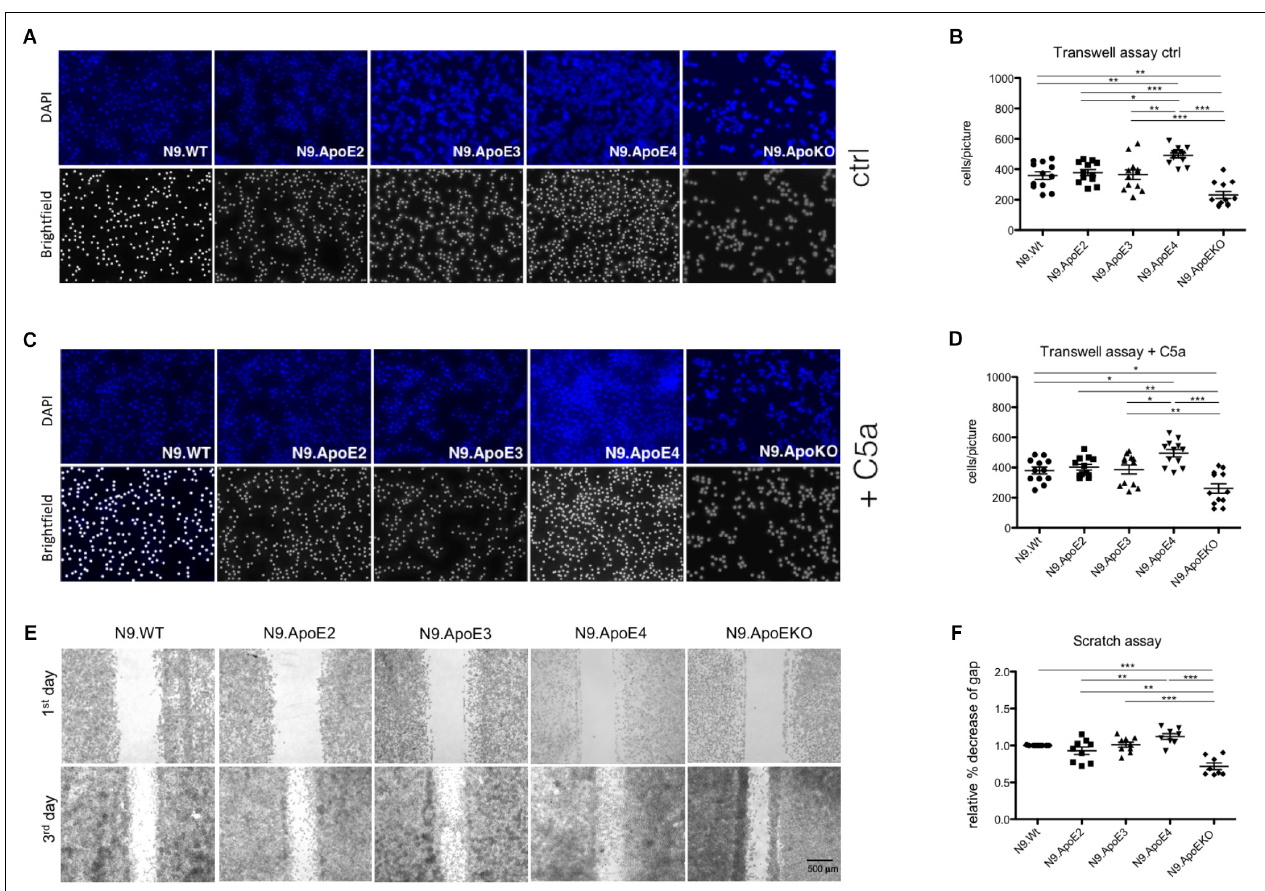
FIGURE 4 | Migration of microglia cells is ApoE-isoform dependent. (A) Representative images of motility in transwell assays and (B) quantification of migrating cell number demonstrate a significant increase in cell motility of N9.ApoE4 and a significant decrease of N9.ApoEKO ( n = 12; magnification 10 × ). (C,D) Representative images of migrating cells toward C5a (20 ng/ml) display a significant increase in cell motility of N9.ApoE4 and a significant reduction of N9.ApoEKO migration ( n = 8; magnification 10 × ). (E,F) Representative images of scratch assay displayed a significant increase in the migration of N9.ApoE4 in comparison to N9.Wt, N9.ApoE2 and N9.ApoEKO confirming the results from transwell assay ( n = 9). Statistical significance was set up at ∗ p < 0.05, ∗∗ p < 0.01, and ∗∗∗ p <